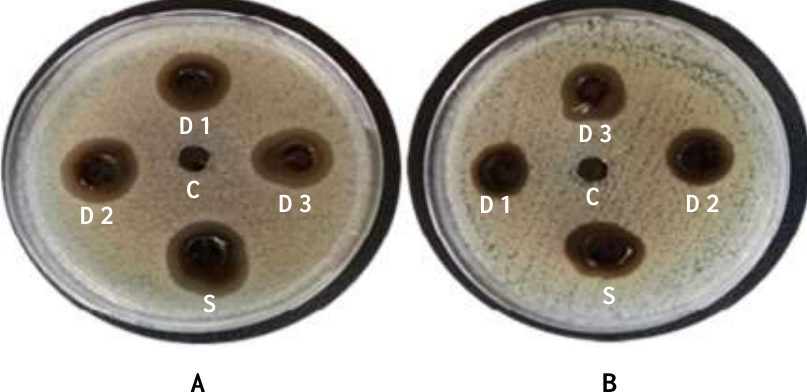
Figure 6 : The antibacterial activity of AgNPs against (A) S. haemolyticus , (B) K. pneomonaie bacteria. Note: (S) refers to 100 %, (D3) refers to 50%, (D2) refers to 25% of AgNPs, (D1) refers to 12.5%, (C) refers to negative